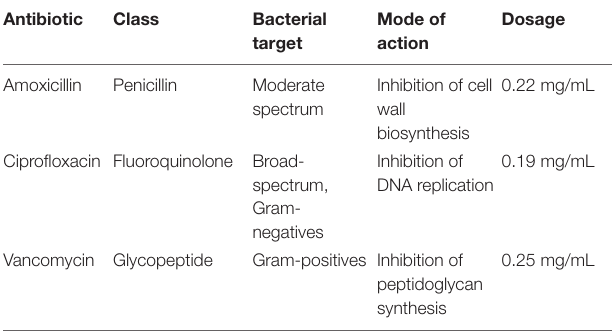
TABLE 2 | Treatment groups. Antibiotics were given to mice based on dosages described in Table 1 . Treatment